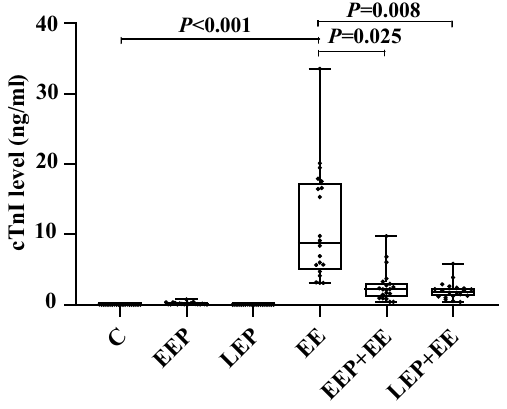
Figure 3. Results of plasma cTnI measurement (K-W test) . Compared with that in group C, the plasma cTnI level was significantly higher in group EE. Compared with that in group EE, the plasma cTnI level was significantly lower in group EEP + EE and group LEP + EE. The results suggested that exhaustive exercise induced myocardial injury and that EP had a protective effect against exhaustive exercise-induced myocardial